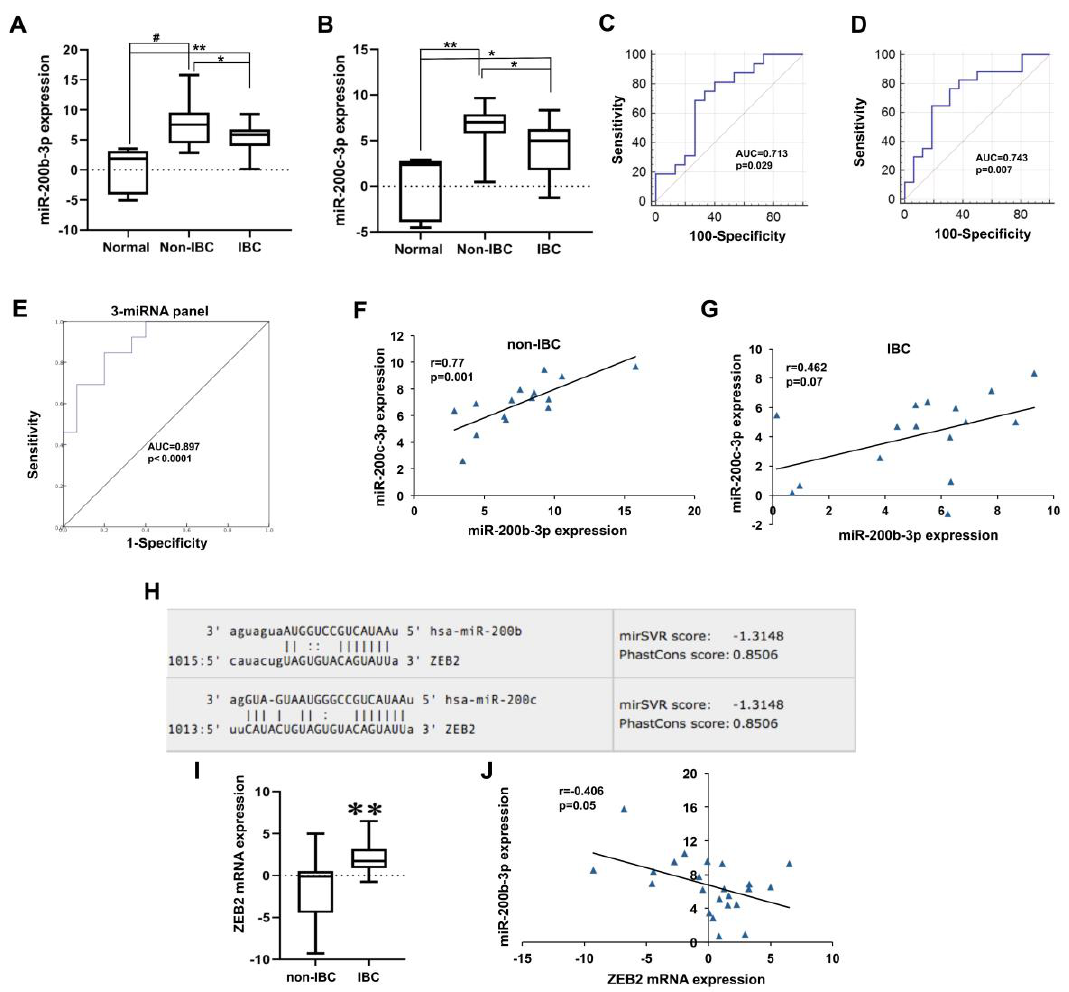
Figure 4. Expression of miR-200b-3p, miR-200c-3p, and their downstream target ZEB2 mRNA in carcinoma tissues of non-IBC and IBC in comparison with normal breast tissue samples. ( A ) miR-200b-3p and ( B ) miR-200c-3p expression levels are significantly repressed in carcinoma tissues of IBC relative to non-IBC as determined by qPCR, whereas their expression levels in non-IBC and IBC are elevated when compared to normal breast tissue samples. miR-200b-3p and miR-200c-3p expression are log2-transformed and normalized to values of normal tissues collected during reduction mammoplasty. # p < 0.001, ** p < 0.01 and * p < 0.05 as determined by Mann-Whitney U-test. ( C ) and ( D ) ROC curves generated using expression levels of miR-200b-3p and miR-200c-3p to discriminate between patients with non-IBC and IBC, respectively. ( E ) ROC curves generated using a combination of expression levels of miR-181b-5p, miR-200b-3p, and miR-200c-3p as a miRNA panel to discriminate between patients with non-IBC and IBC. ( F ) and ( G ) Spearman’s correlation between miR-200b-3p and miR-200c-3p expression in carcinoma tissues of non-IBC and IBC, respectively. ( H ) Predicted target sites of the zinc finger E box-binding homeobox 2 ( ZEB2 ) 3′UTR aligned with the seed sequence of miR-200b-3p and miR-200c retrieved from the microRNA.org database. ( I ) The expression of ZEB2 mRNA levels is upregulated in carcinoma tissues of IBC vs. non-IBC. ** p < 0.01 as determined by Mann-Whitney U-test. ( J ) An inverse association between ZEB2 and miR-200b-3p expression in breast cancer tumors as determined by Spearman’s correlation. Together, this suggests that changes in the expression of miR-200b-3p and miR-200c-3p from high levels in non-IBC to low levels in IBC may have an influence on epithelial-to-mesenchymal transition (EMT) and mesenchymal-to-epithelial transition (MET) phenotypes of the tumor entity, and in turn its pathogenesis and progression. This can be further influenced by the regulation of expression levels of their direct downstream targets. As expected, we observed a significant positive